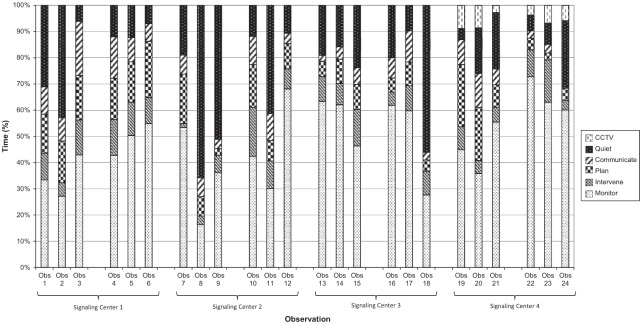
Observation results.